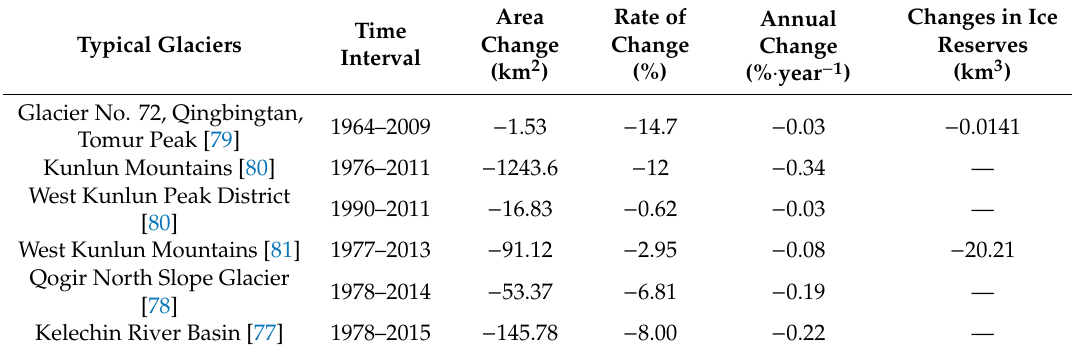
Table 4. Changes of typical glaciers in the TRB during recent